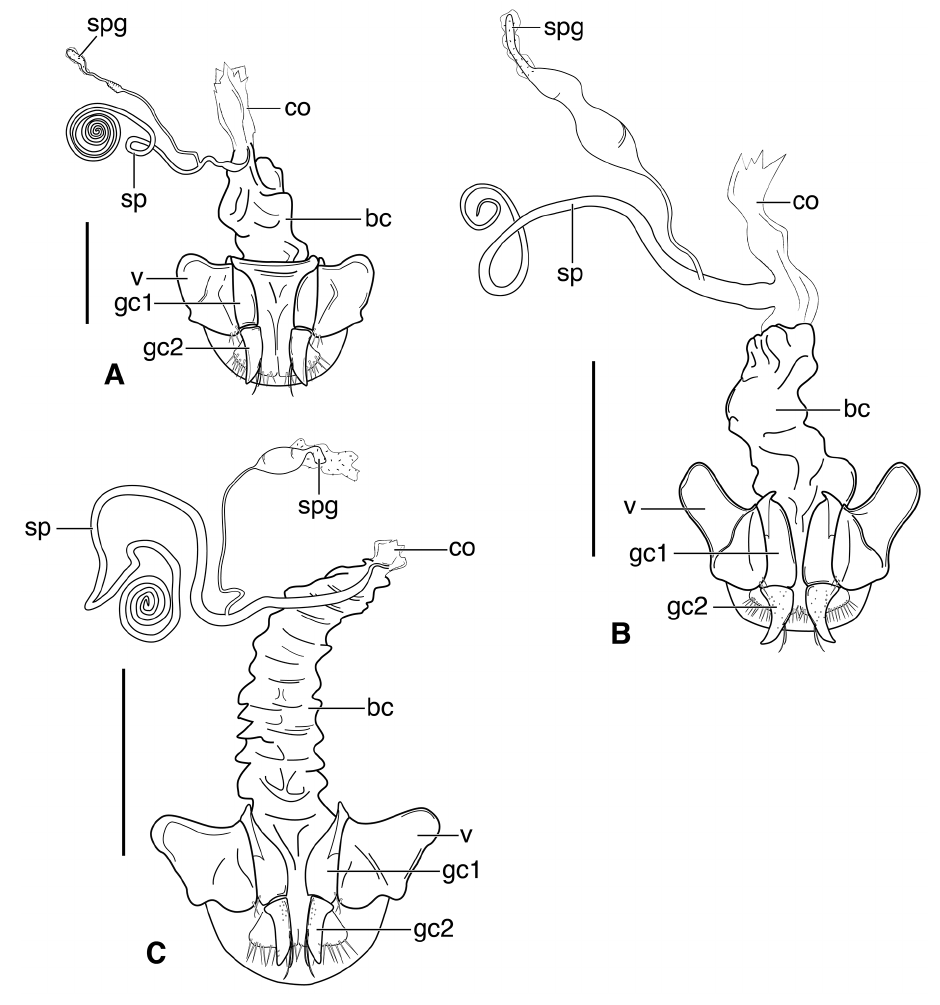
Figure 7. Line drawings of female reproductive tract of Amblygnathus species, ventral aspect. A A. cepha- lotes Dejean B A. puncticollis (Putzeys) C A. gilvipes gilvipes Ball & Maddison. Legend: bc bursa copula- trix; co common oviduct; gc1 gonocoxite 1; gc2 gonocoxite 2; sp spermatheca; spg spermathecal gland; v valvifer. Scale bars 1